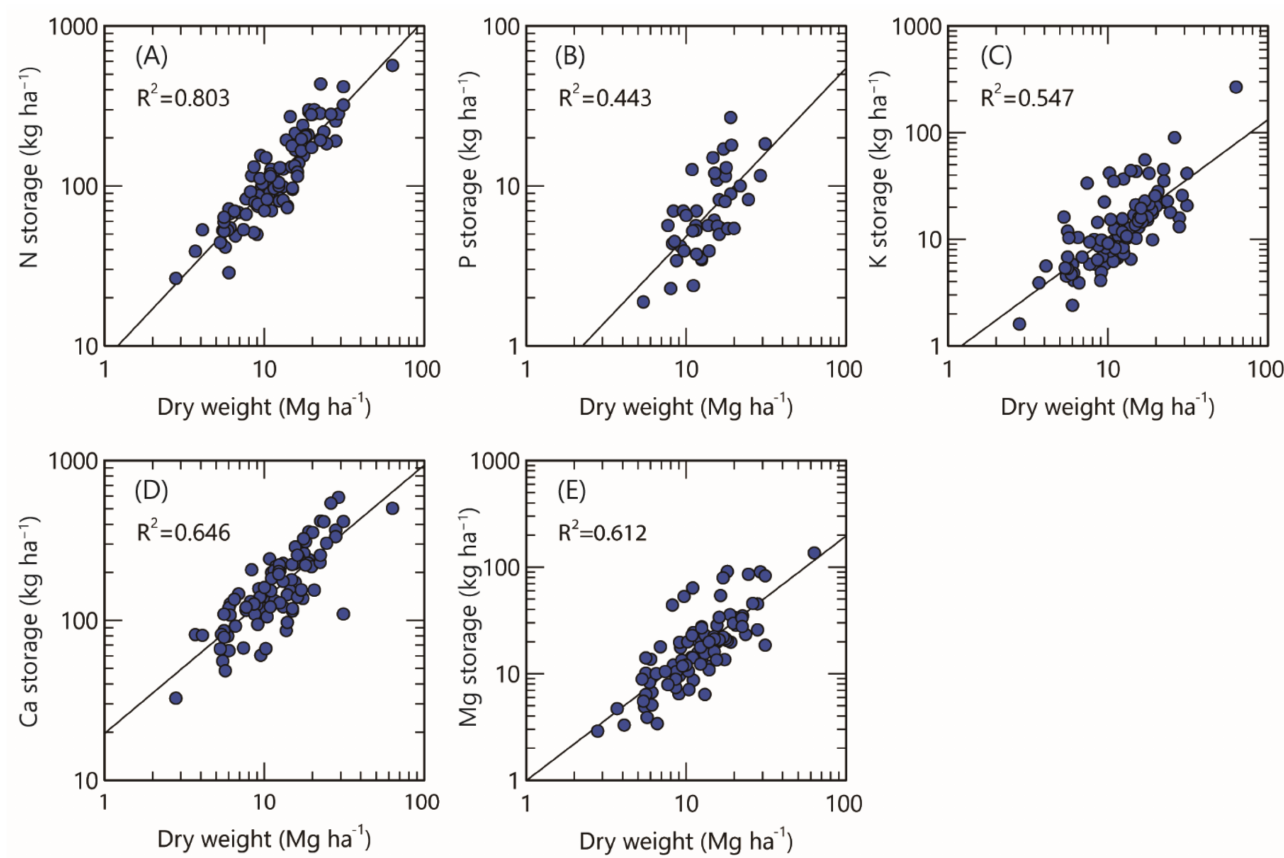
Figure 5. Relationship between nutrient storage (nitrogen ( A ), phosphorus ( B ), potassium ( C ), calcium ( D ), and magnesium ( E )) and dry weight of the forest floor in Japanese cedar plantations. Regression equations are shown in Table